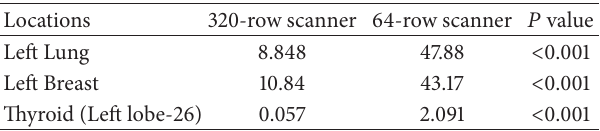
Table 3: Comparison of ARD (mGy) for radiosensitive organs (Lung, Breast and Thyroid) between dose modulation imaging at 320-row MDCT versus dose modulation method at 64-row MDCT.